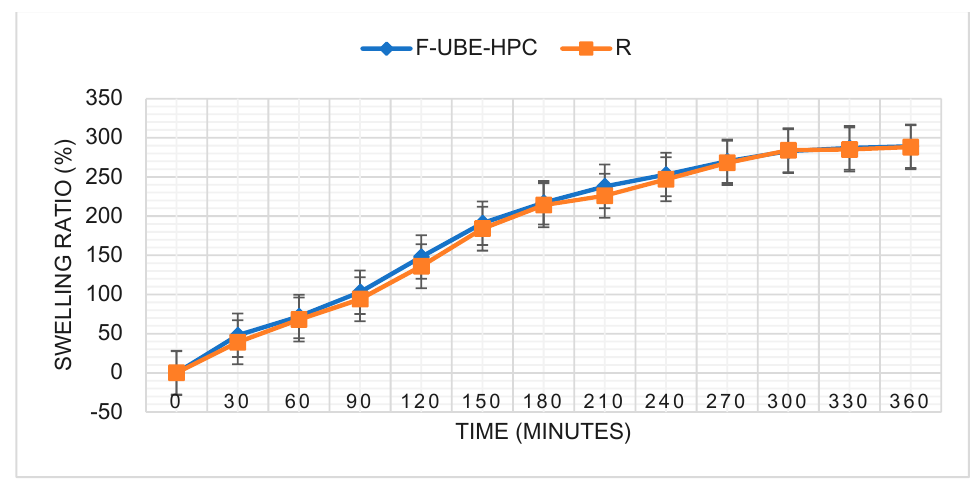
Figure 5. Swelling rate over 6 h for F-UBE-HPC and R; F-UBE-HPC—bioadhesive oral film loaded with U. barbata dry ethanol extract; R—bioadhesive oral film without active lichen extract.